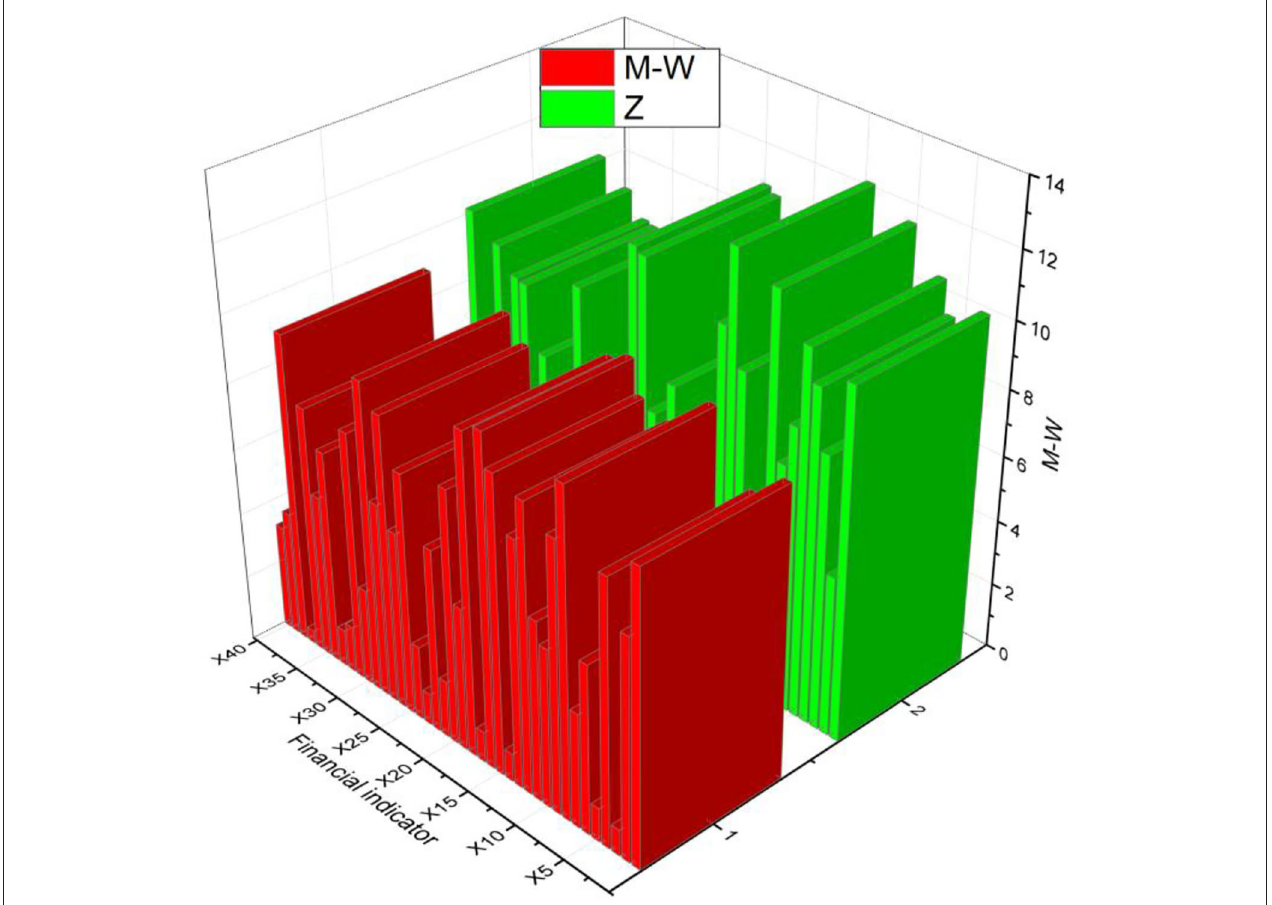
FIGURE 5 | Non-parametric test